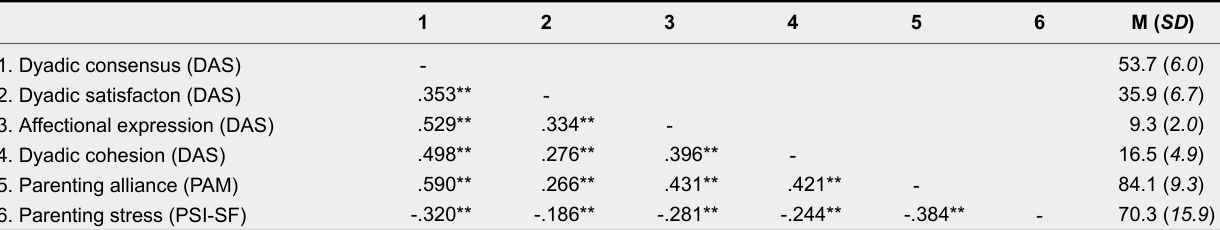
Descriptive Statistics and Correlations for Marital Adjustment (DAS), Parenting Alliance (PAM), and Parenting Stress (PSI-SF) in Mothers (N = 236)